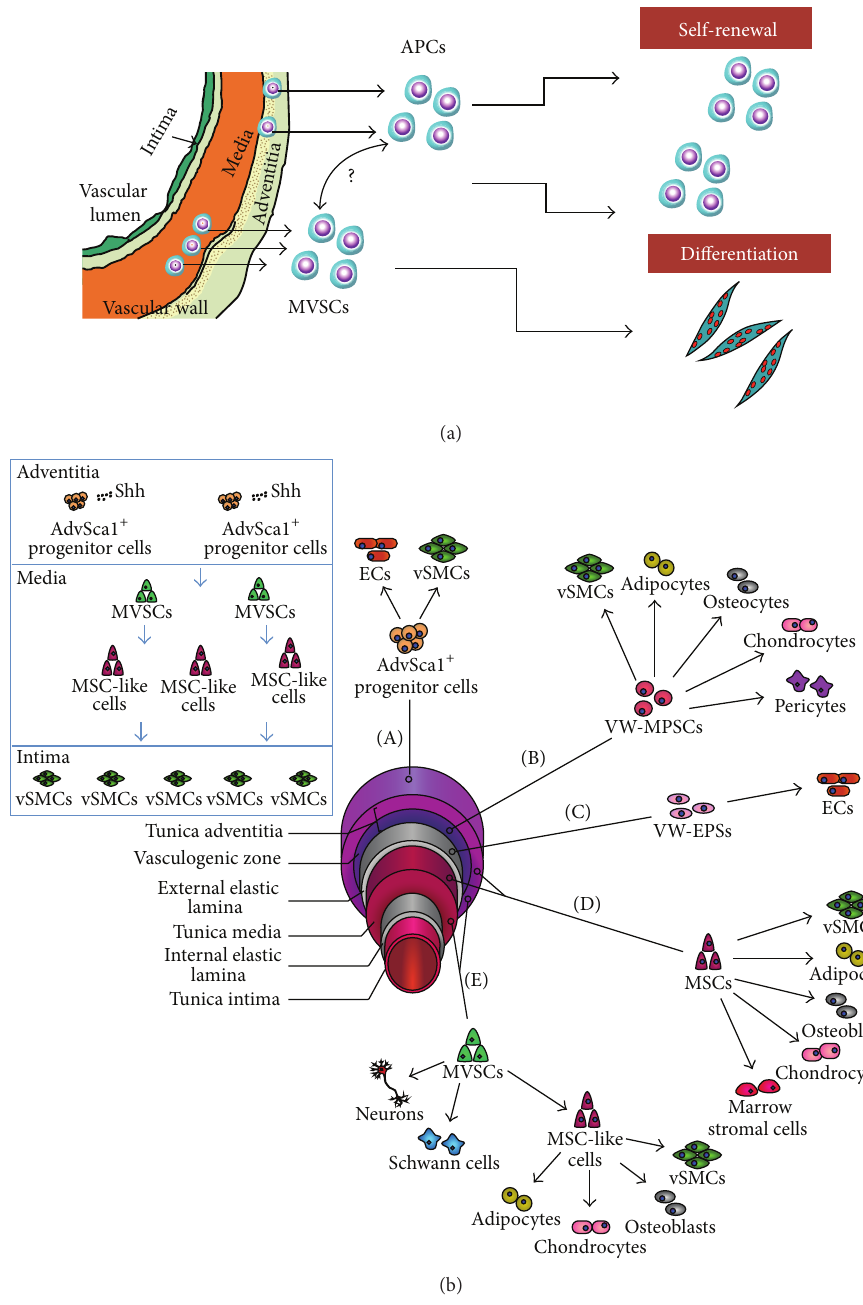
Figure 5: (a) APC and MVSC locations within the blood vessel wall. AdvSca1 + progenitor cells reside in the tunica adventitia and MVSC reside within the medial adventitial boundary and are both capable of transition to SMCs. (b) Differential potential of the resident stem and progenitor cells present in the blood vessel. AdvSca1 + progenitor cells (APC) reside in the tunica adventitia and have the ability to differentiate into ECs and vSMCs. VW-EPS were isolated from the vasculogenic zone of the tunica adventitia. These cells can differentiate into vSMCs, adipocytes, osteocytes, chondrocytes, and pericytes. VW-EPS were found in the external elastic lamina and were shown to form capillaries in culture and increase expression of mature EC markers during the process. MSCs have been isolated from both the tunica media and the tunica adventitia and have been shown to differentiate into adipocytes, osteoblasts, chondrocytes, marrow stromal cells, and SMCs. MVSCs were present in the tunica media and have the ability to differentiate into neurons, Schwann cells, and MSC-like progenitor cells. Once the MVSCs have transitioned into a MSC-like state they are capable of differentiating into adipocytes, osteoblasts, chondrocytes, and vSMCs. Inset: Hedgehog regulation of progenitor cells present in the vessel